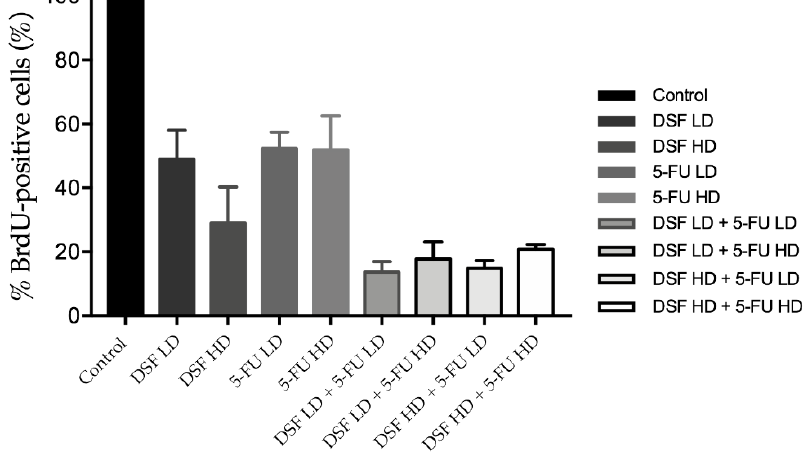
Figure 11. The individual and combined effect of DSF and 5-FU on cell proliferation of Ca-Ski cells determined using a BrdU assay. Table 7. Multiple comparisons between low and high dose DSF versus low and high dose 5-FU and different combination doses of DSF and 5-FU. The results highlighted in bold italics report a lower cell replication by administering the 2 combined drugs at the lowest doses compared with both the single low and high dose of DSF or 5-FU. DSF LD = 40 μM; DSF HD = 75 μM; 5-FU LD = 10 μM; 5-FU HD = 20 μM.